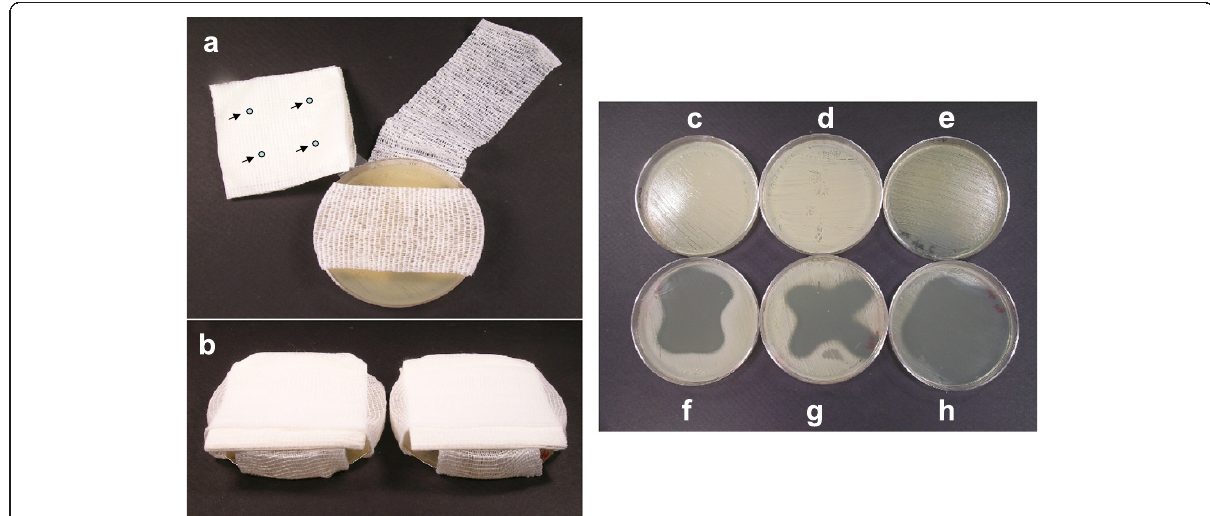
Figure 1 Dressing model using an agar plate. ( a ), arrows indicate the CPV spots on gauze dressing pad; ( b ), complete setup of dressing model with gauze dressing pad wrapped with bandage. Untreated control plates of S. aureus strains ( c ), COL; ( d ), Mu50; and ( e ), 13136 p - m + V 20 . Inhibition of S. aureus (f), COL; (g), Mu50; and (h), 13136 p - m + V 20 caused by